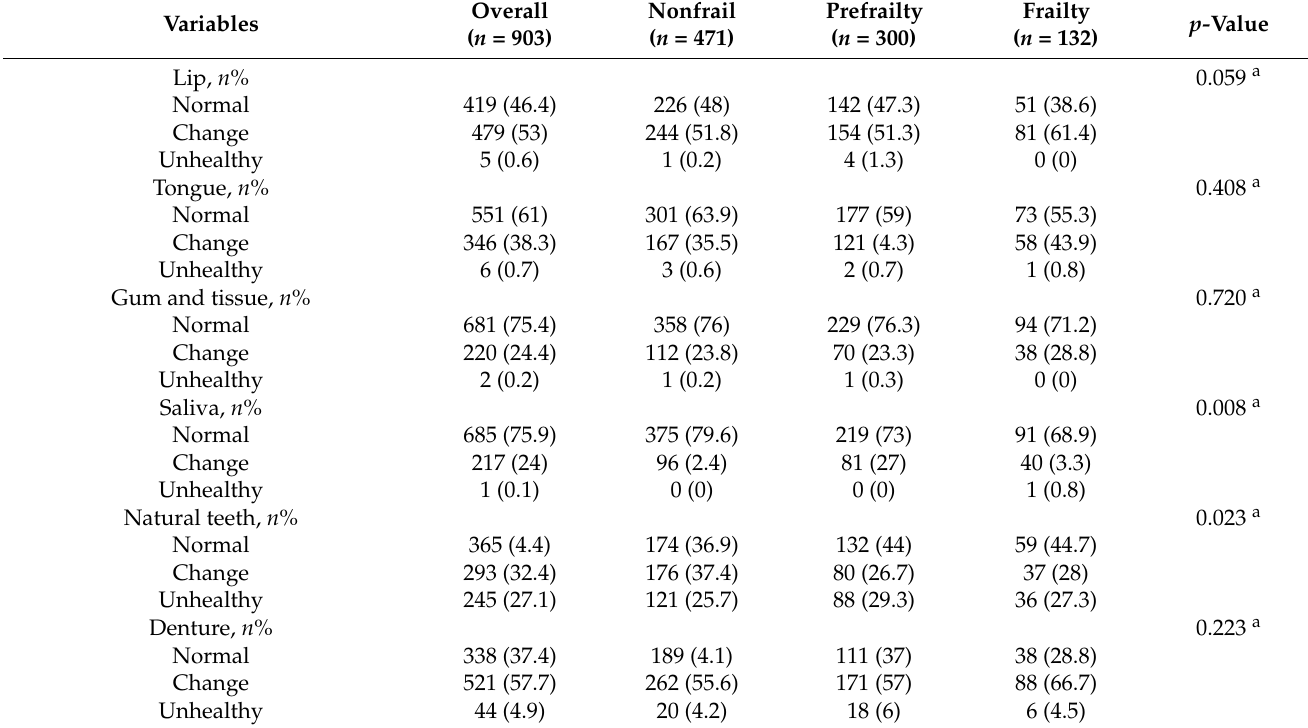
Table 3. OHAT and subdomains for elderly people with different frailty